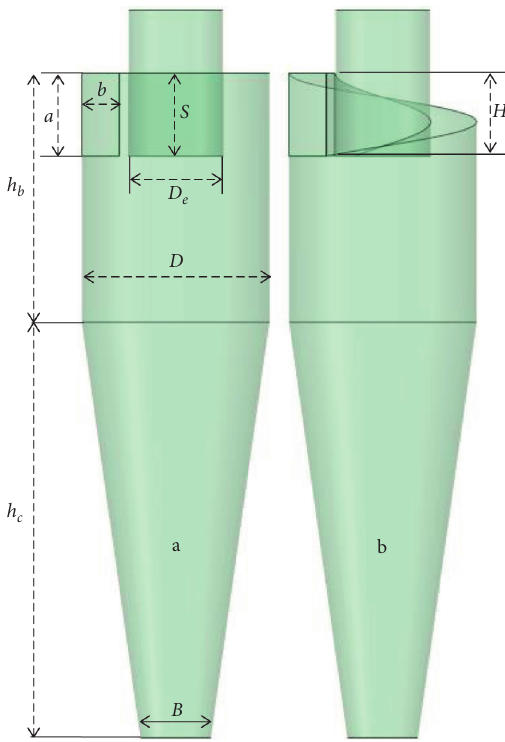
Figure 1: Schematic representation of (a) Stairmand high-efficiency type and (b) helical roof type Table 1: Dimensions of the cyclones.